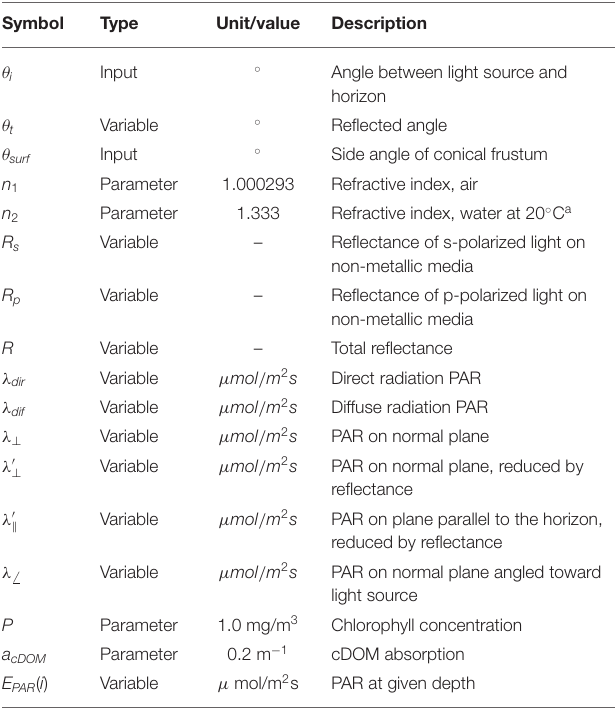
TABLE 1 | Summary of inputs, variables, and parameters used in light calculations. Symbol